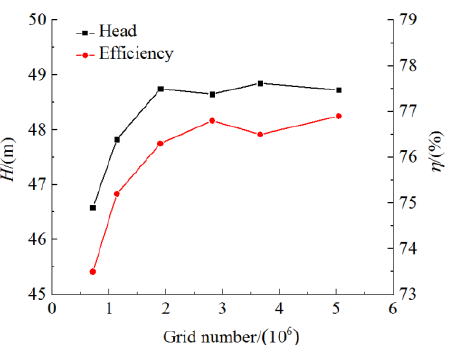
Figure 2. Fluid domain grid of PAT.